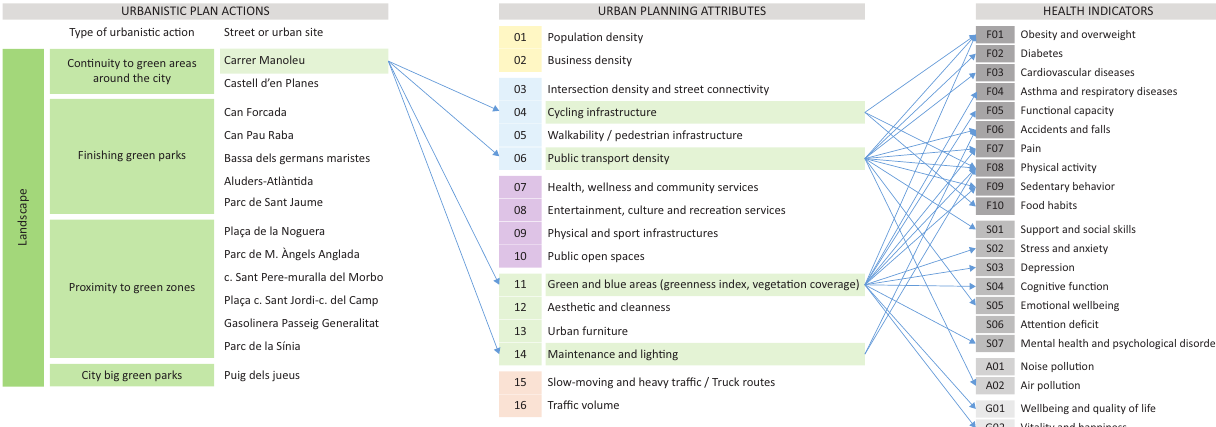
Figure 7. Example of how urban planning actions included in the Vic Urban Master Plan were linked to the health‐related urban planning attributes and health indicators.